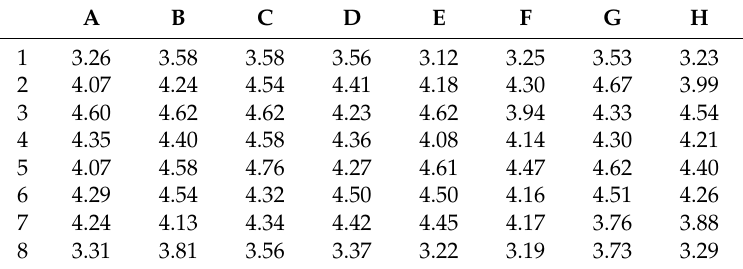
Table 2. FMT results of air velocity distribution (m/s).